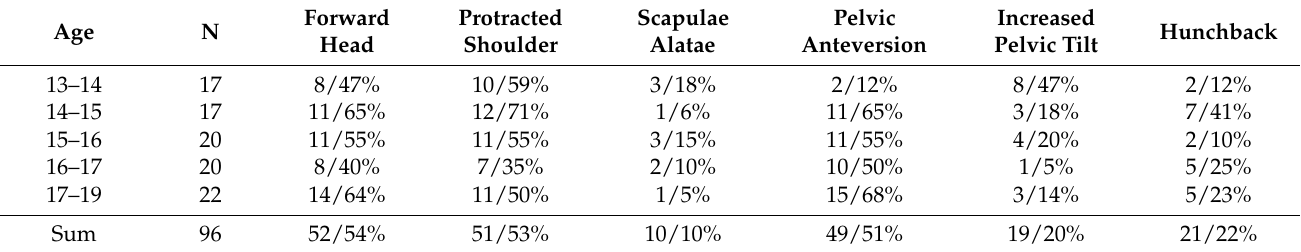
Table 2. Prevalence of postural deviations in the studied population (absolute N/prevalence).